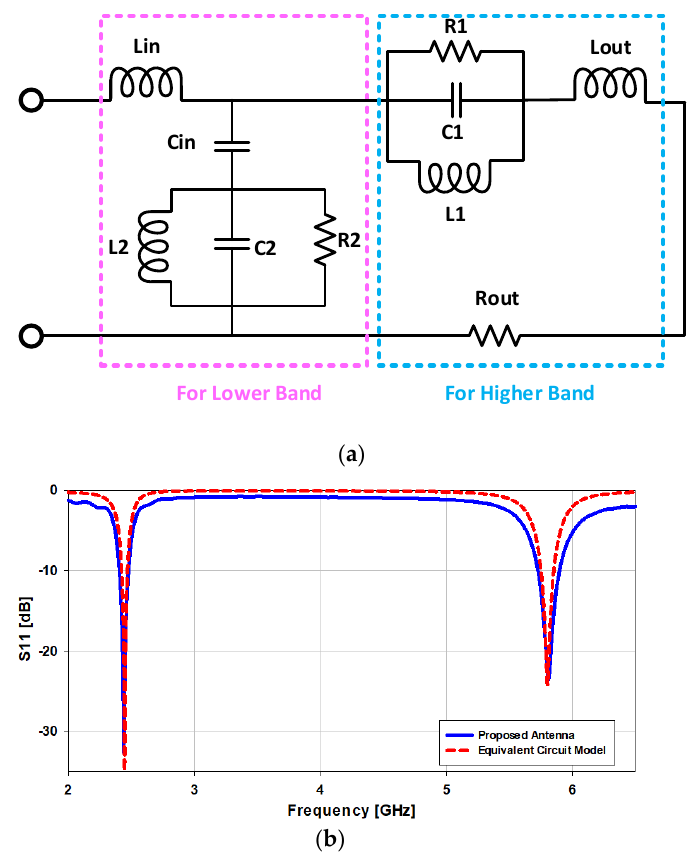
Figure 6. Surface current distribution ( a ) at 2.45 GHz and ( b ) at 5.8 GHz.